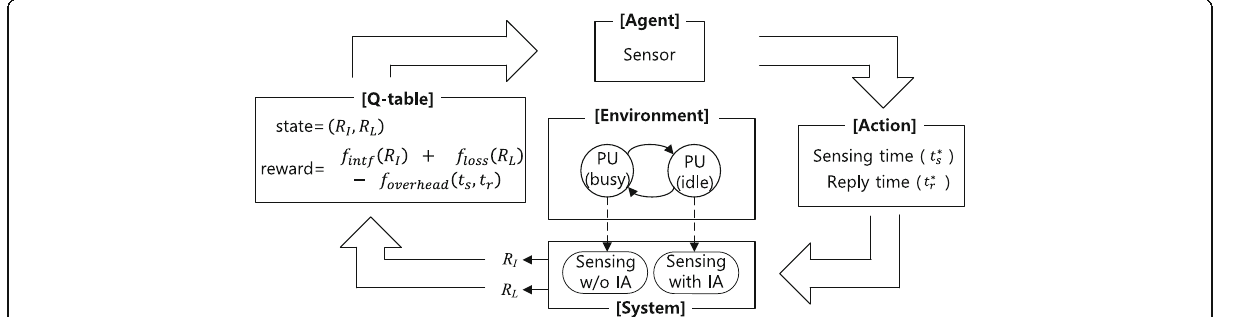
Fig. 8 Q-learning mechanism of the proposed scheme. In the proposed Q-learning system, the sensor acts as an agent and uses sensing time and reply time as an action. In an environment where the PU operates in an alternating busy/idle state, it obtains the interference ratio and the transmission opportunity loss ratio for the action, and uses it to change the state and calculate the reward